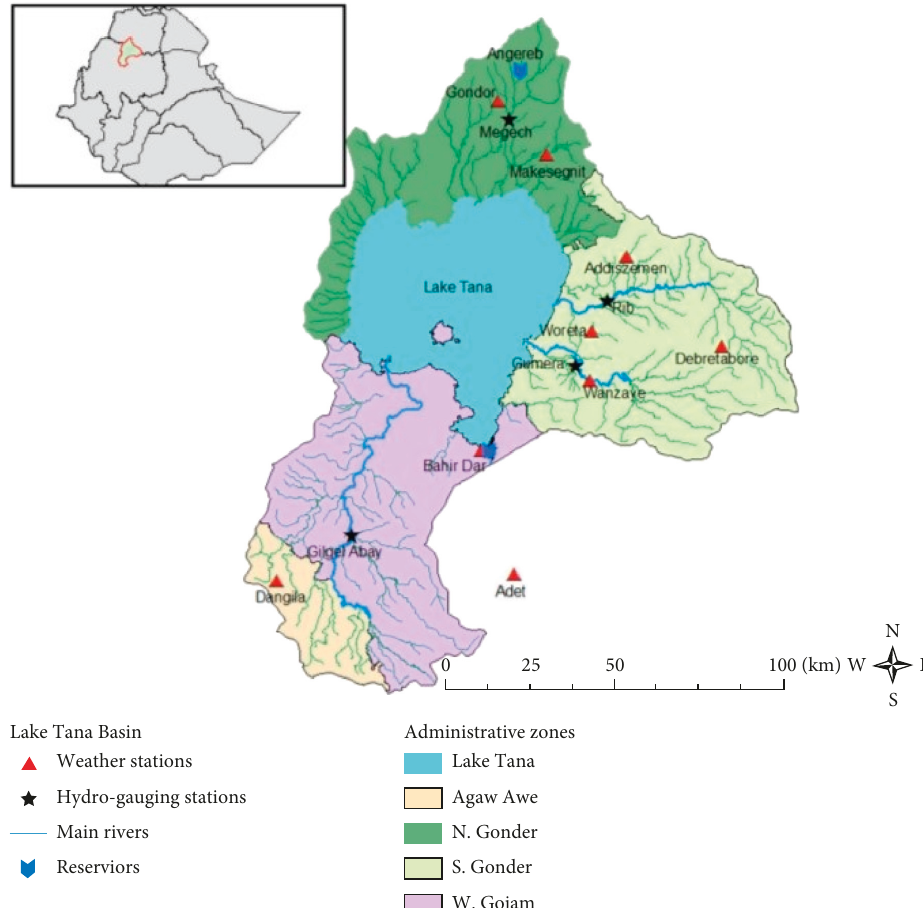
Figure 1: The location of the Lake Tana Basin in the Ethiopian and the Upper Blue Nile Basin system with meteorological stations